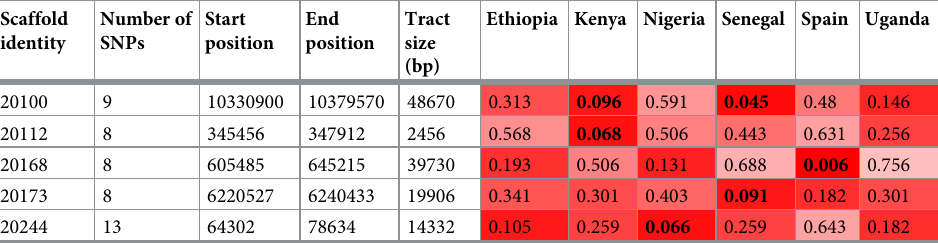
Table 3. Characteristics of the five S . haematobium -like genomic tracts detected in at least one S . bovis isolate and Dxy values computed between each S . bovis isolate and all the S . haematobium isolates within each of these five S